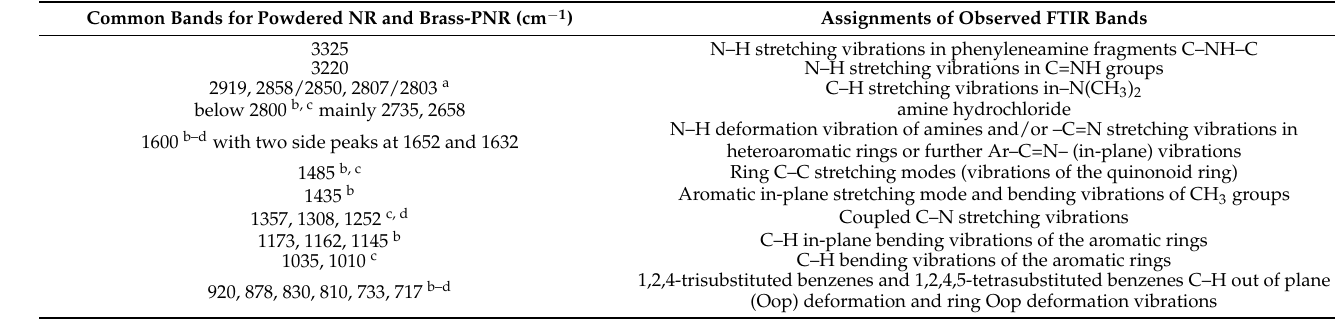
Table 1. Comparing infrared spectra of powered neutral red (NR) and the PNR film deposited on the brass plate (brass-PNR). Common Bands for Powdered NR and Brass-PNR (cm − 1 ) Assignments of Observed FTIR